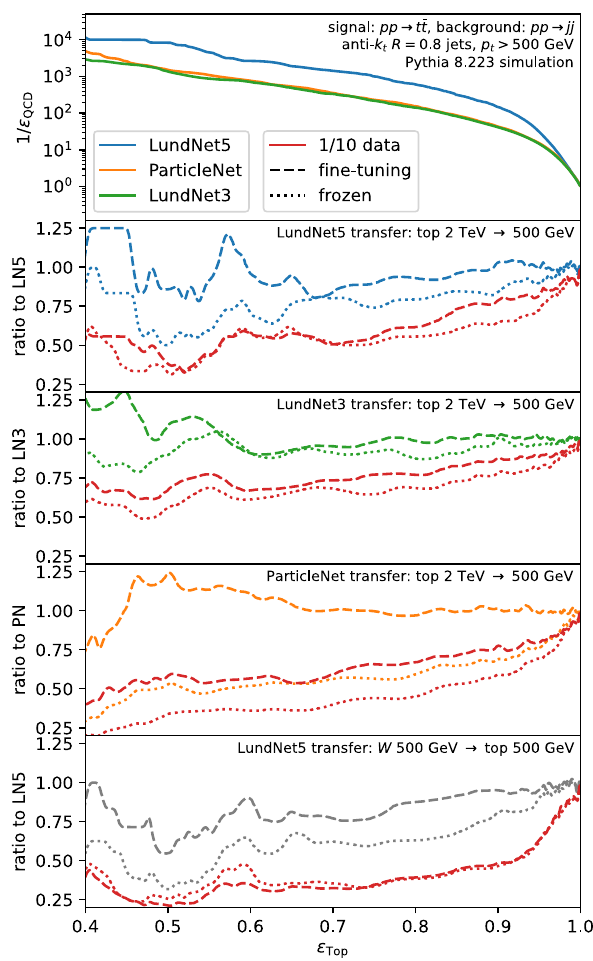
Fig. 5 QCD rejection vs. top tagging